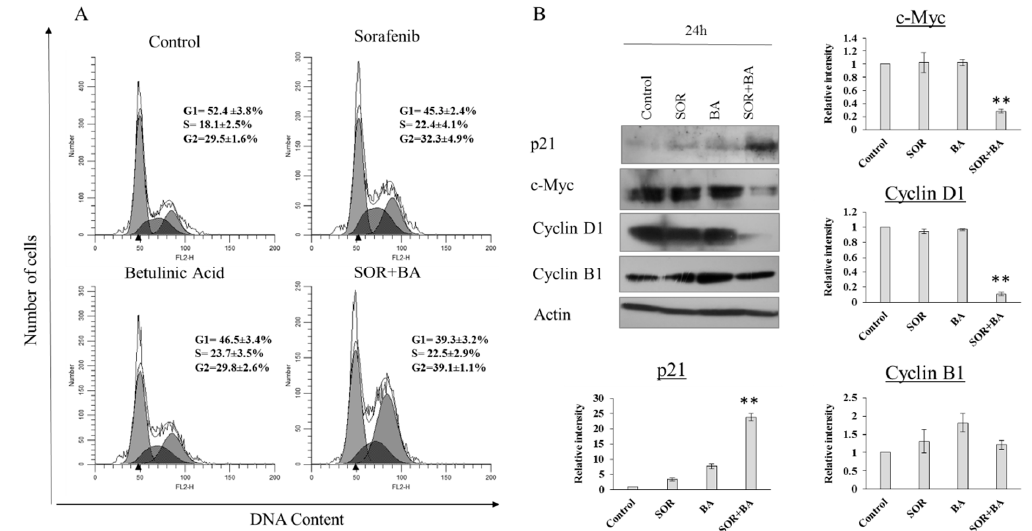
Figure 3. Effect of combination treatment with SOR and BA on cell cycle arrest in AsPC-1 cells. ( A ) Representative cell cycle analyzed by FACS of AsPC-1 cells after treatments with sorafenib (5 µM) and betulinic acid (6 µM) alone and in combination ( n = 3). ( B ) Representative immunoblot of p21, c-Myc, cyclin D1, and cyclin B1 expression from AsPC-1 cells treated with sorafenib (5 µM) and betulinic acid (6 µM) alone and in combination ( n = 3). Actin served as a loading control. Data are presented as means ± SD. * p < 0.05, ** p < 0.01 compared with the sorafenib treatment group and betulinic acid treatment group. All experiments were repeated at least three times. Int. J. Mol. Sci. 2018 , 19 , x FOR PEER REVIEW 2.3. Combination Treatment with Sorafenib and Betulinic Acid Inhibits the Expression of the PI3K/Akt and MAPK Signaling Pathways in the AsPC-1 and BxPC-3 Cell Lines